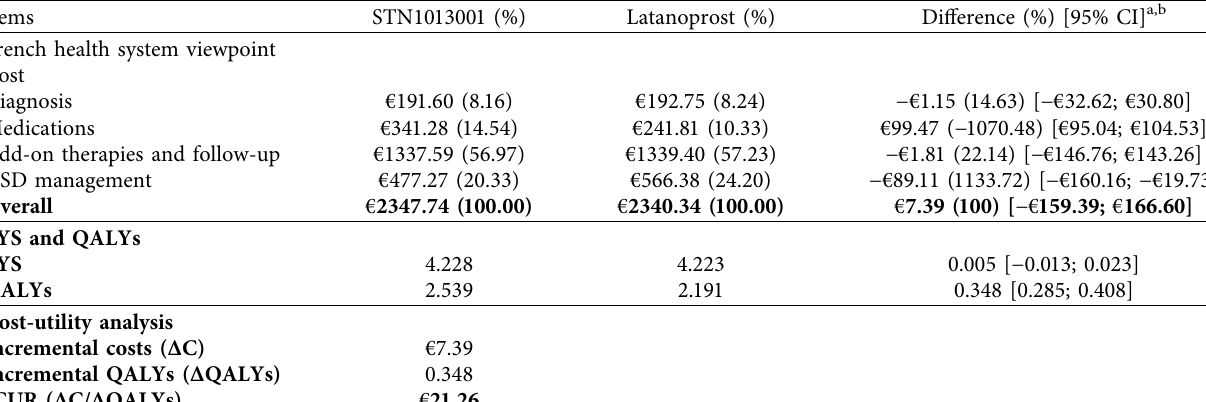
Table 2: Base case analysis–results–costs per patient and cost-utility analysis ( €